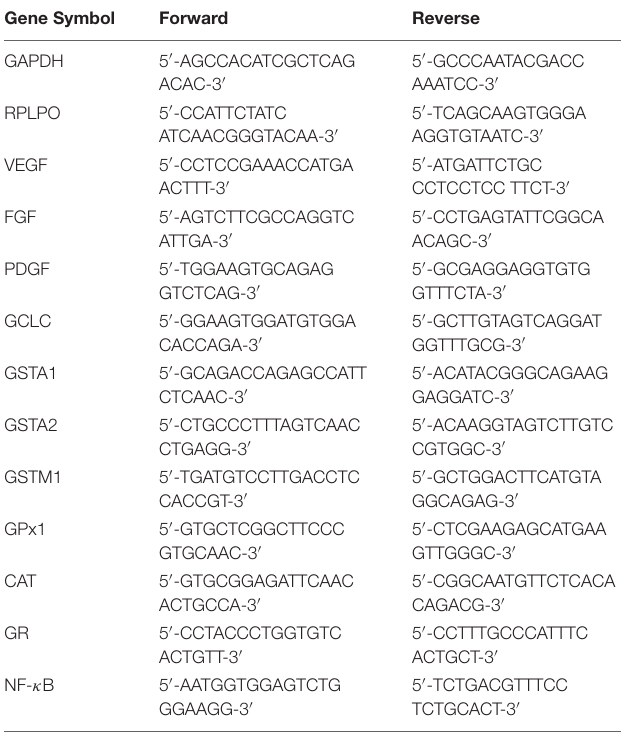
TABLE 2 | Sequence of the primers used in Real Time